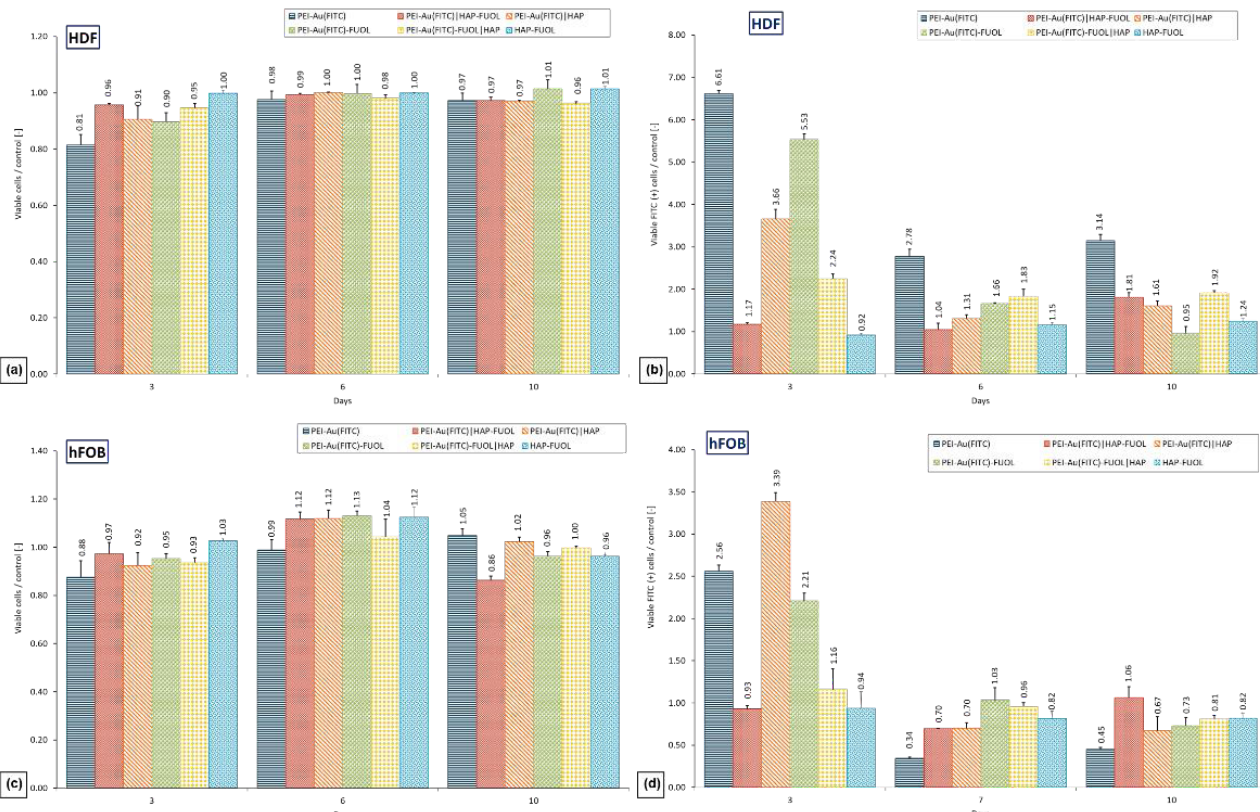
Figure 5. Percentage rate to the control of viable ( a ) HDF or ( b ) HDF FITC (+) and ( c ) hFOB hFOB or ( d ) hFOB FITC (+) cells maintained in the presence of polyelectrolyte membranes after 1-, 5- and 10-day culture. The values are presented as the mean ± SD. Abbreviations: Au, gold nanoparticles; FITC, Fluorescein isothiocyanate; FUOL, fullerenol; HAP, hydroxyapatite; HDF, Human Dermal Fibroblasts; PEI, polyethylenimine.